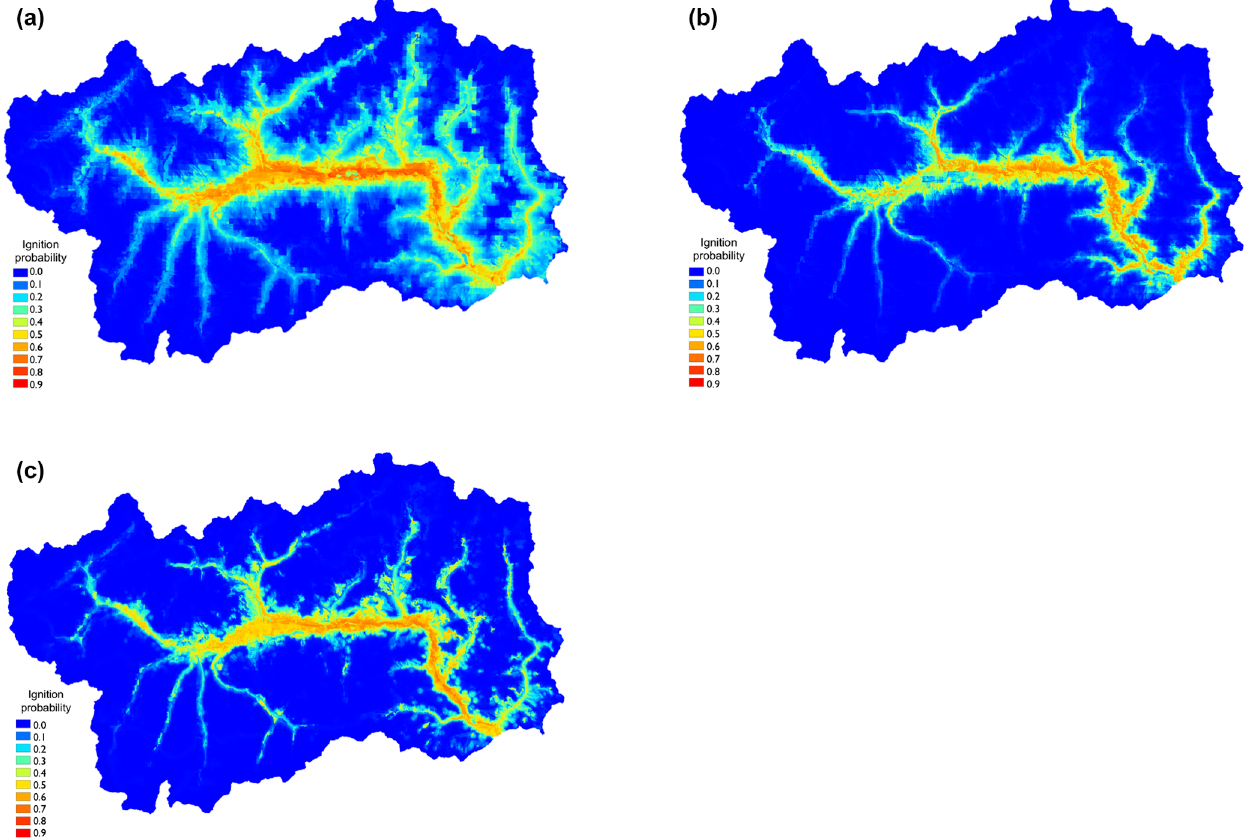
Figure 9. Ignition probability in the study area for summer fires (a) , winter forest (b) , and winter agropastoral fires (c)